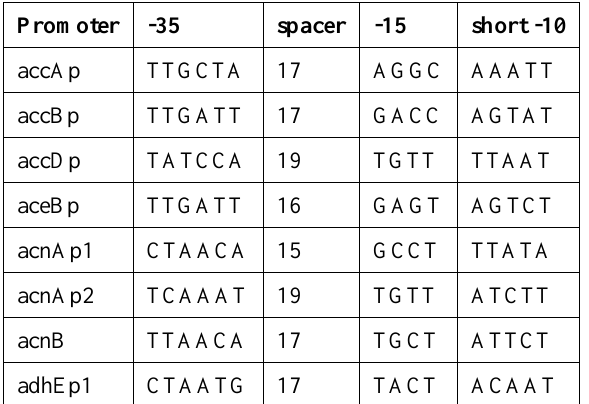
Table 1: Examples of promoter sequence